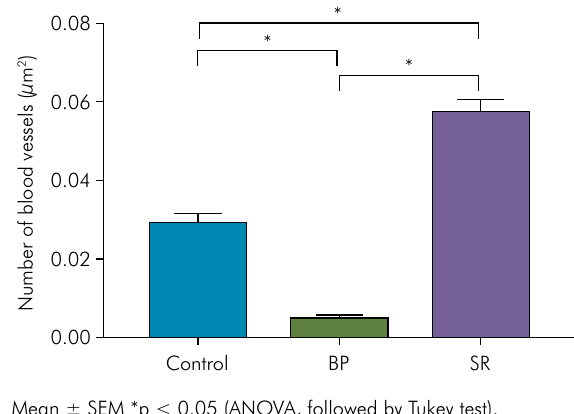
Figure 7. Increased number of blood vessels in the SR group. Observe the decrease in the bisphosphonate-treated group.